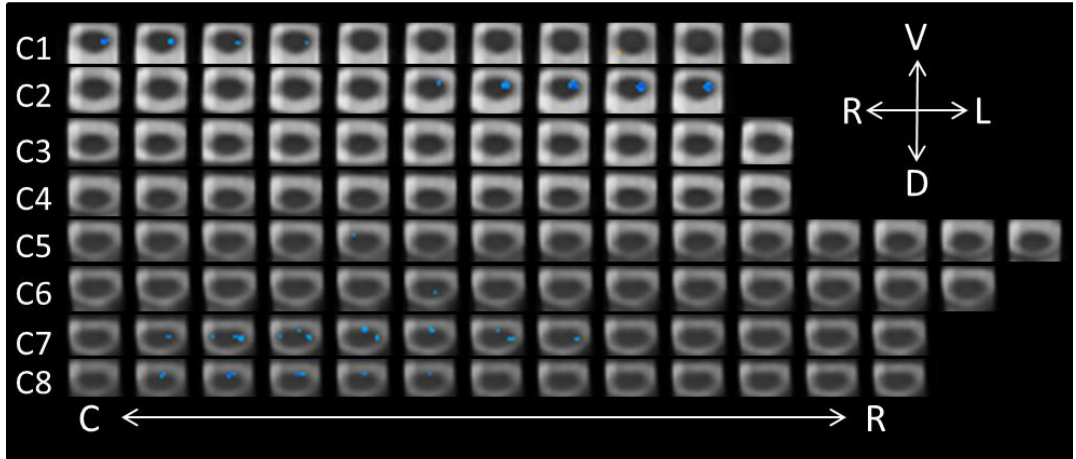
Figure 5. Axial spinal cord slices presenting the distribution of activity produced during the Neutral-unconscious/Fear-unconscious contrast (−1, 1). The images are oriented in radiological convention with dorsal towards the bottom of each frame, left side of the cord on the right of each frame, and are displayed caudal-to-rostral from left to right of each row (α = 0.00556). The abbreviations related to the axial directions (top-right of the figure) are defined as follows: R = right; L = left; V = ventral; D = dorsal. The abbreviations C and R (bottom of the figure) refer to caudal and rostral, respectively.